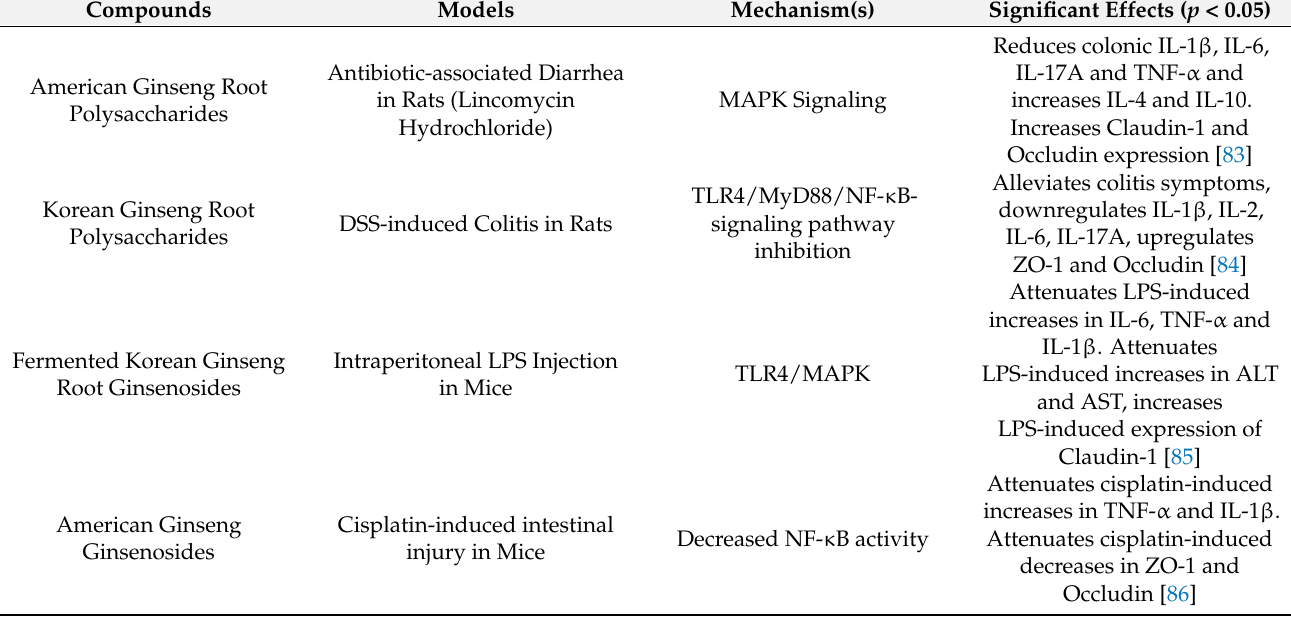
Table 2. Direct effects of ginseng on the intestinal barrier